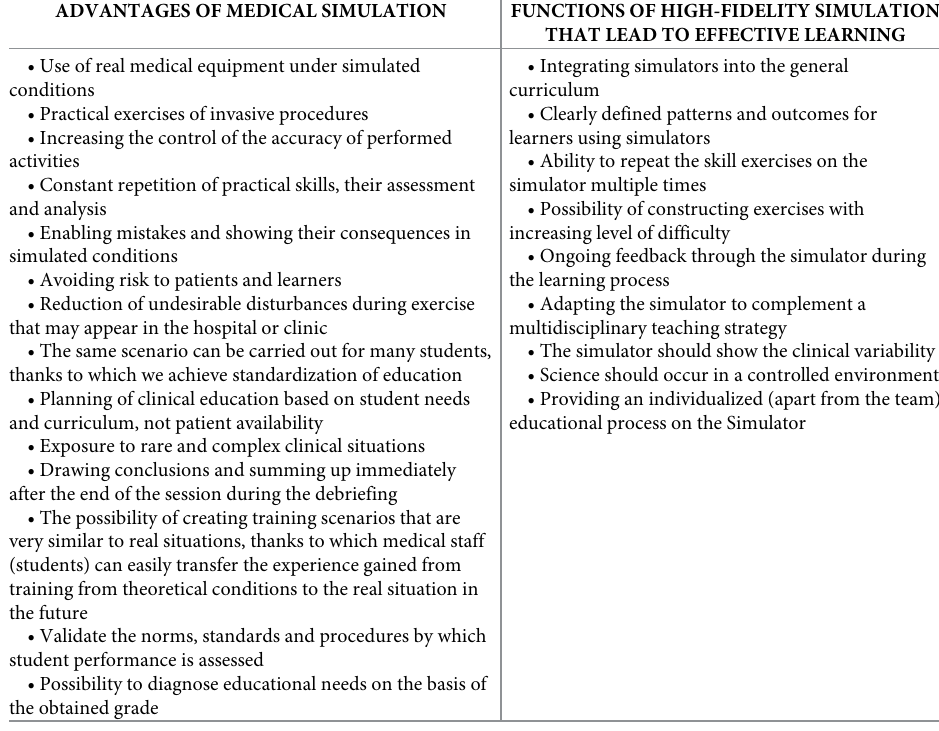
Table 1. Advantages of medical simulation and effective